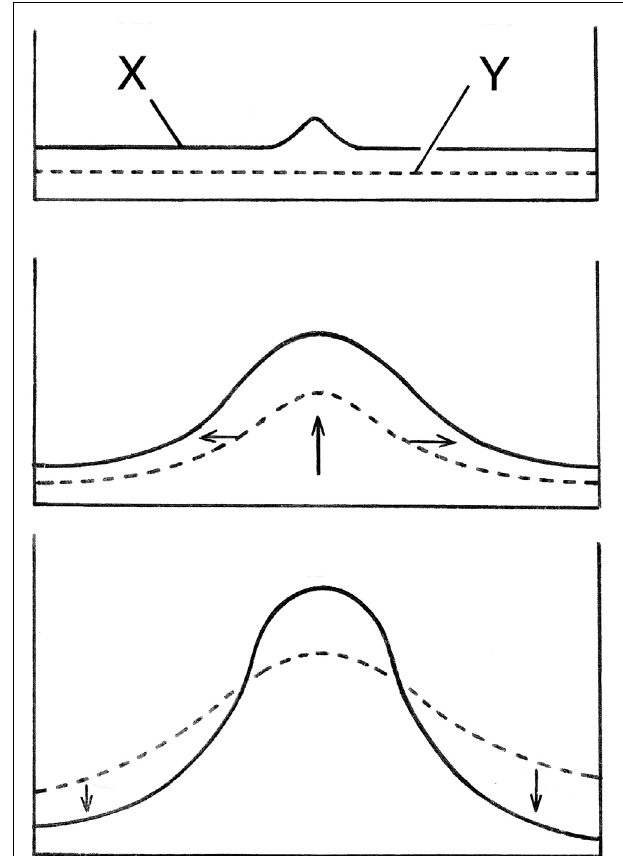
FIGURE 1 | A simple explanation of how Turing’s mechanism generates a spatial pattern, here shown as concentrations peaks for two diffusing substances, X and Y, which interact such that X stimulates its own production and that of Y, while Y inhibits X production. The homogeneous steady state is maintained by a balance between supply and degradation of both substances, so this is an open, dissipative system, and with appropriate parameter values, the steady-state is unstable. A random deviation in X from the steady-state will then grow (top frame), which stimulates extra Y formation, so Y grows as well (middle frame, vertical arrow). Y diffuses more rapidly (horizontal arrows), and so spreads laterally and drives down X (bottom frame), thus stabilizing the central peak in X. This provides an intuitive understanding of the mechanism works, but largely conceals the crucial role played by statistical behavior at the molecular